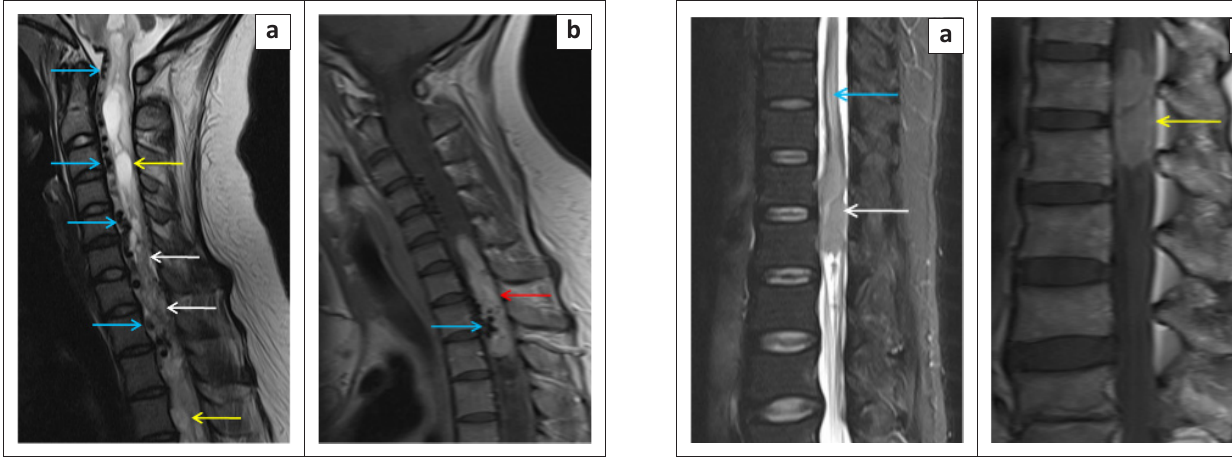
FIGURE 7: Lymphoma of the conus medullaris in a 52-year-old man. Sagittal T2-weighted image (a) reveals a hyperintense mass (white arrow) in the conus medullaris with an exophytic growth pattern. Syrinx formation (blue arrow) is also seen. Contrast-enhanced sagittal T1-weighted image (b) demonstrates a well-circumscribed homogenously enhancing mass (yellow arrow) in the conus